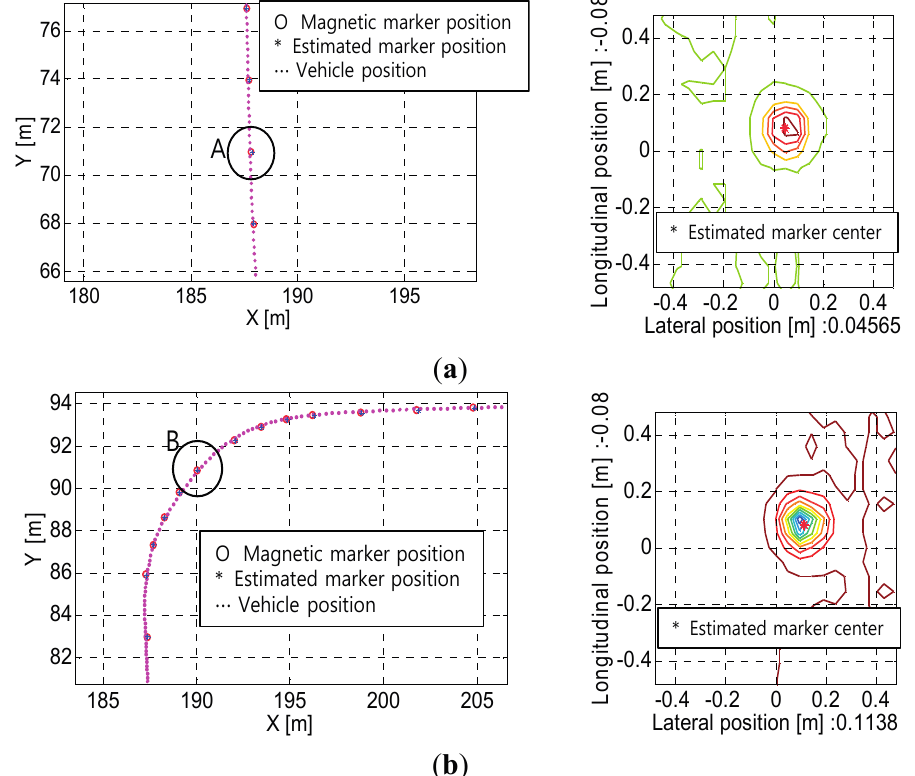
Figure 14. Comparison of estimation results in operation at: ( a ) Straight sections of the route; ( b ) Curved sections of the